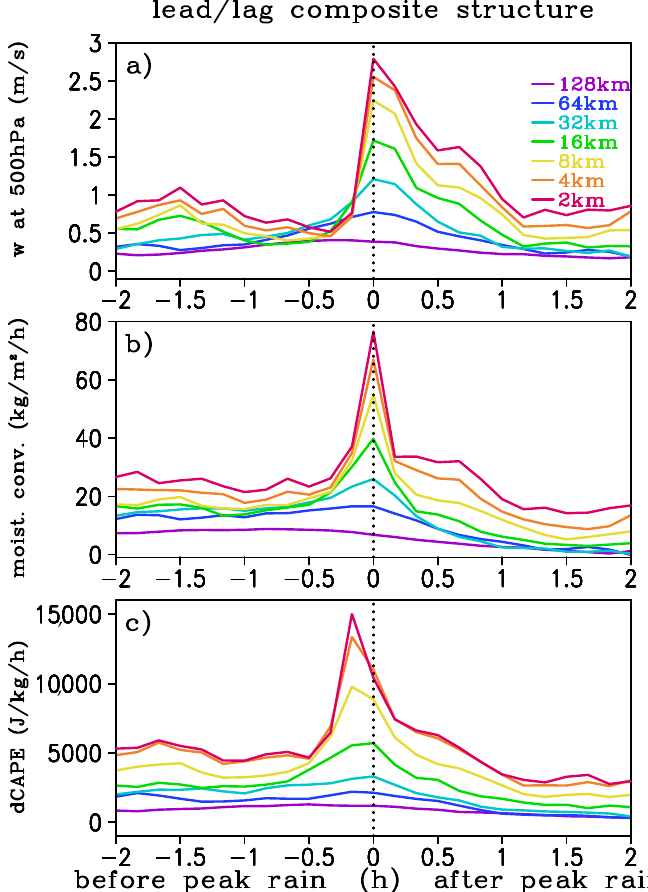
Figure 12. Lead / lag composite structure of ( a ) vertical velocity at 500 hPa (m / s), ( b ) moisture convergence (kg / m 2 / h) and c) large-scale CAPE change (J / kg / h) for various subdomains. Zero value on the x-axis is the time of peak convective precipitation. Negative (positive) values on x-axis represent the large-scale variable leading (lagging) convective precipitation by a given amount of time.